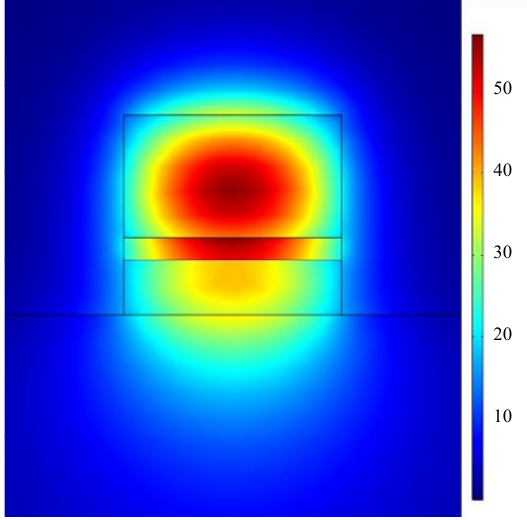
Fig. 3. Mode field distribution of the designed polymer horizontal slot